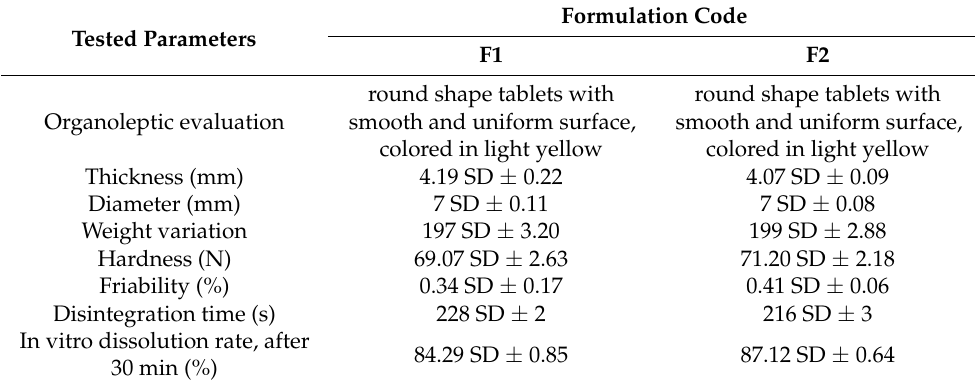
Table 7. The pharmaco-technical evaluation of the tablets. Tested